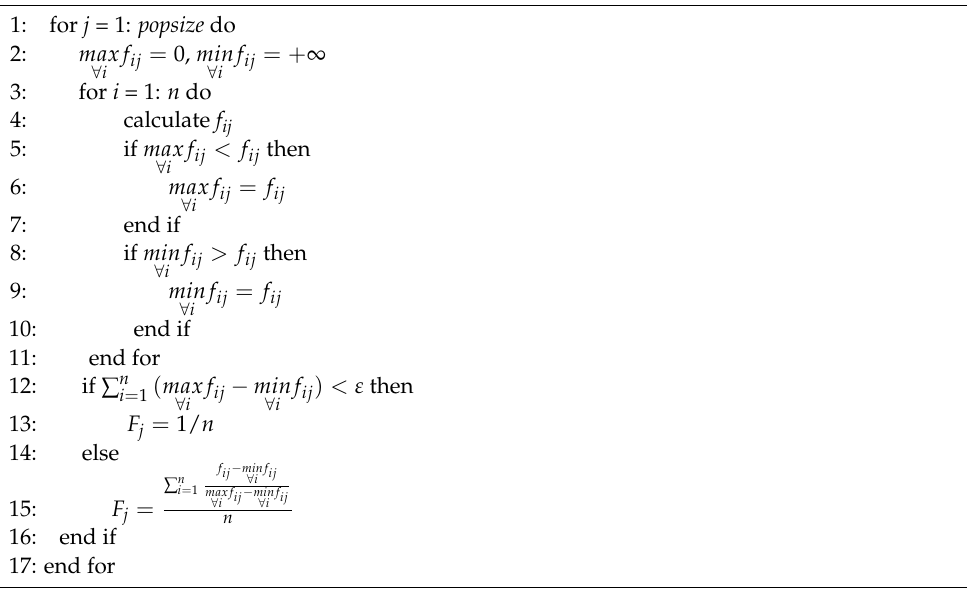
Algorithm 1. Evaluation for each